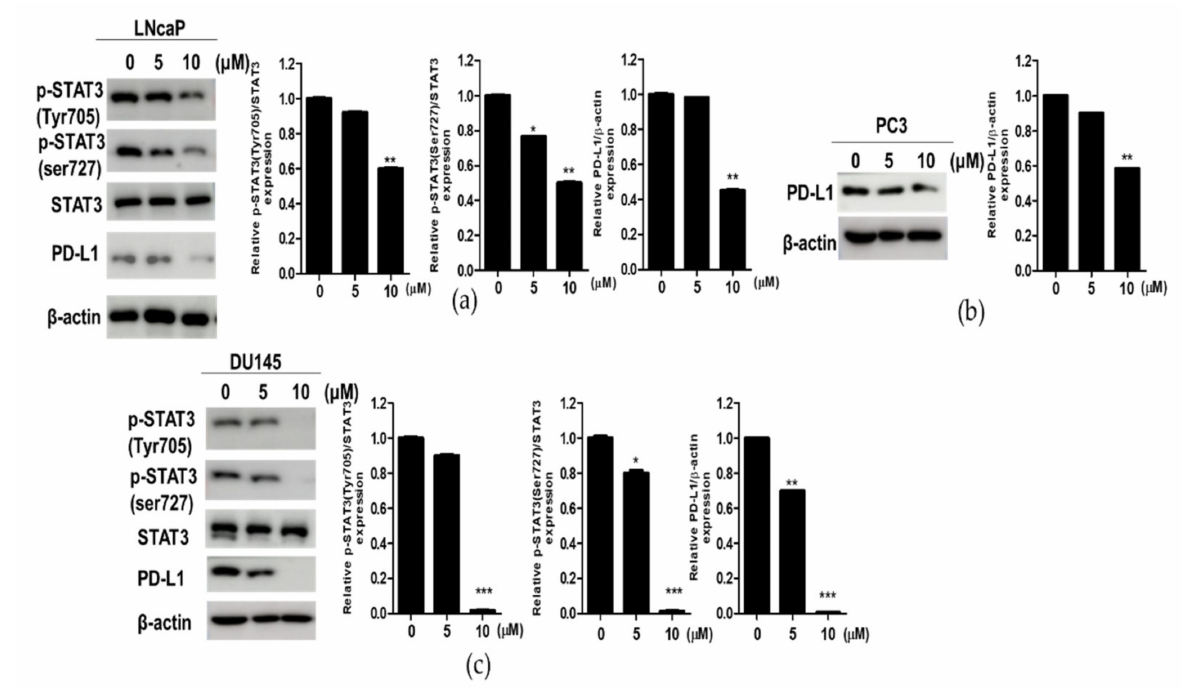
Figure 3. Effect of compound K on the expression of p-STAT3 (Tyr705), p-STAT3 (ser727), STAT3 and PD-L1 in prostate cancer cells. ( a ) LNCaP cells were treated with CK (0, 5 or 10 µ M) for 24 h and subjected to Western blotting for p-STAT3 (Tyr705), p-STAT3 (ser727), STAT3 and PD-L1. ( b ) PC3 cells were treated with CK (0, 5 or 10 µ M) for 24 h and subjected to Western blotting for PD-L1. ( c ) DU145 cells were treated with CK (0, 5 or 10 µ M) for 24 h and subjected to Western blotting for p-STAT3 (Tyr705), p-STAT3 (ser727), STAT3, PD-L1 and β -actin. Graphs represent relative levels of protein/ β -actin. Data represent means ± SD. * p < 0.05, ** p < 0.01 and *** p < 0.001 versus untreated